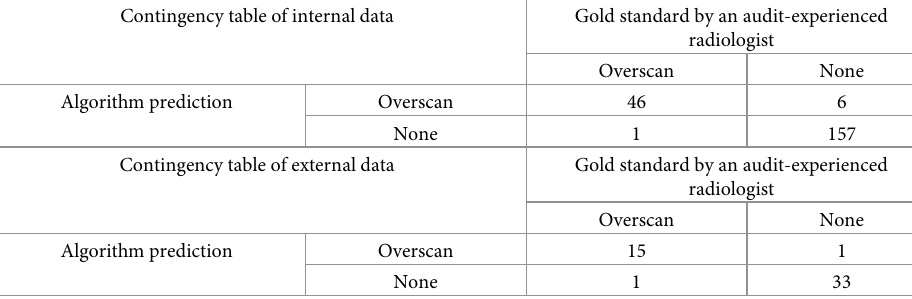
Table 2. Contingency table of decision model validation with internal and external